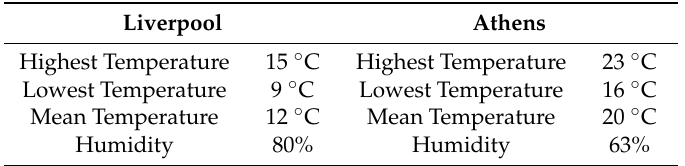
Table 3. Average climate data in October for Liverpool and Athens [28,29].